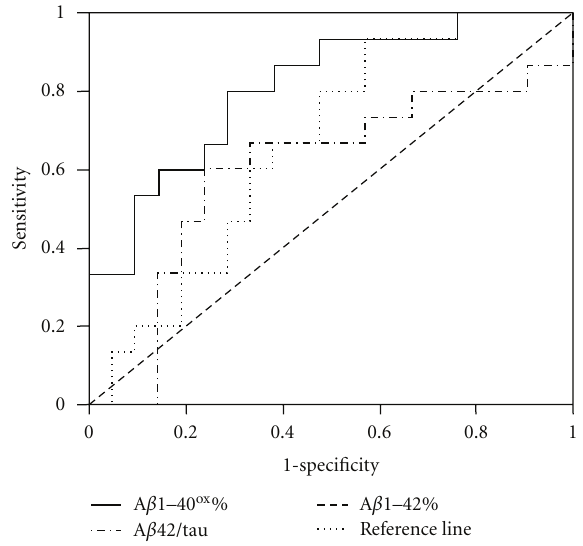
Figure 3: Receiver operator curves for di ff erentiating DLB from PDD using A β 42/tau, A β 1–42% and A β 1–40 ox %,